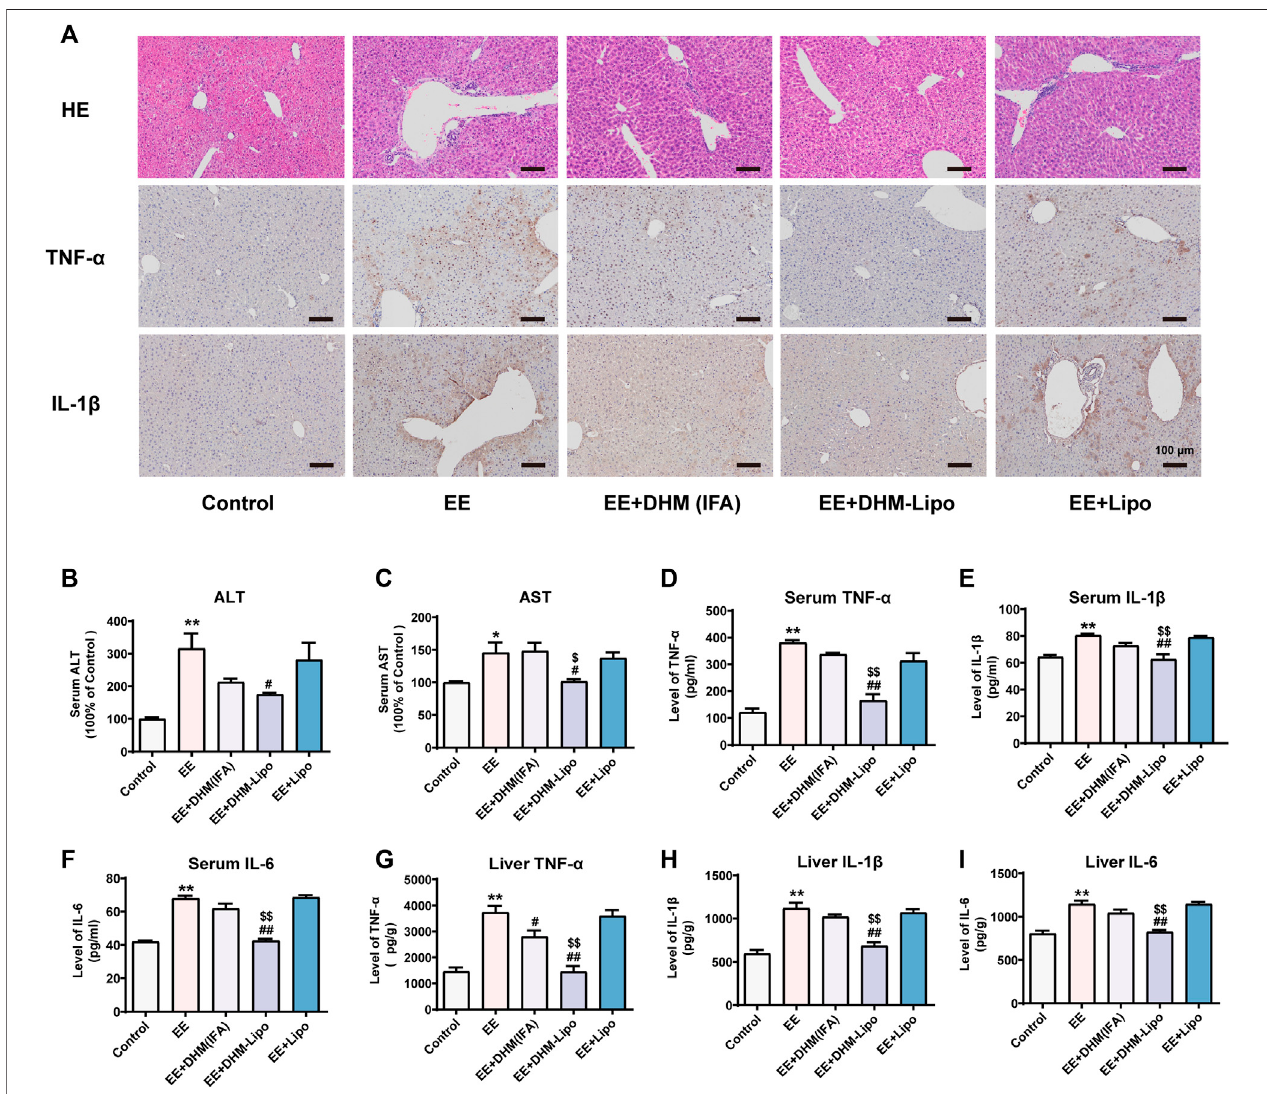
FIGURE 3 | DHM-Lipo administration ameliorated EE-induced liver in fl ammation in vivo (A) Liver in fl ammation was examined by H&E and IHC for TNF- α and IL-1 β (B – C) Serum levels of ALT and AST were examined (D – I) The expression of the in fl ammatory cytokines TNF- α , IL-1 β , and IL-6 in mouse serum samples (D – F) and mouseliversamples (G – I) wasexaminedbyELISA.Dataarepresentedasthemean±SEM( n =5).* p < 0.05,** p < 0.01,comparedtothecontrolgroup; # p < 0.05, ## p < 0.01, compared to the EE group; $ p < 0.05, $$ p < 0.01, compared to the EE + DHM (IFA) group. Scale bar, 100 μ